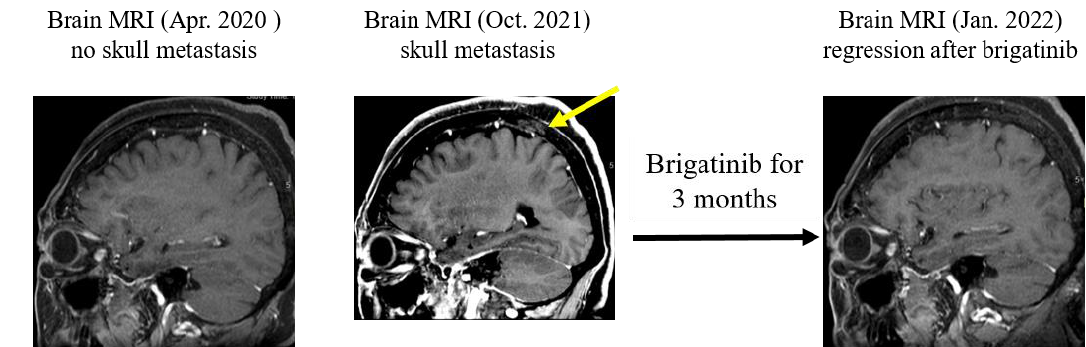
Figure 4. During immunochemotherapy, the patient had headache and dizziness. Brain magnetic resonance imaging (MRI) showed focal metastasis in the parietal skull (middle panel in October 2021). Three months after brigatinib treatment, the skull lesion regressed (right panel in January